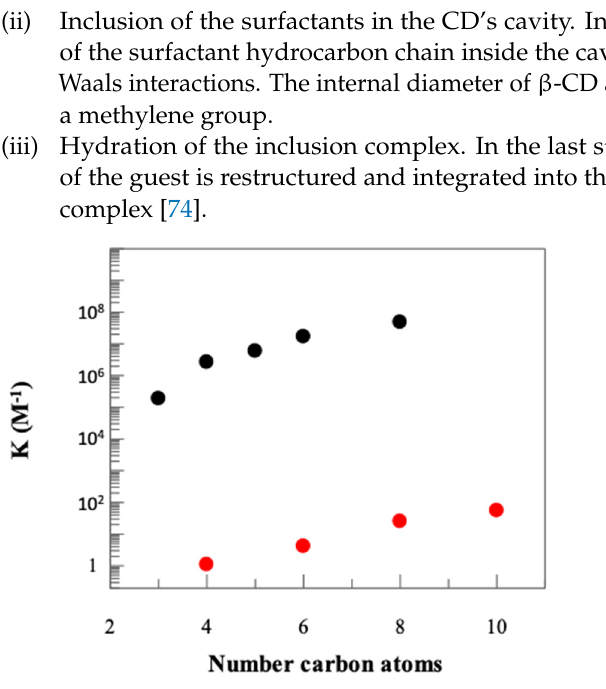
Figure 8. ( ● )Influence of alkyl chain length of alkylsulfonates on their binding constants to pil- lar[5]arene using a [pillararene] = 0.04 mM at 25 °C. Value for propanesulfonate was extrapolated from [host] = 0.25 mM (see text). ( ● ) Binding constants for alkylsulfonates to β -cyclodextrin taken from ref. [73].